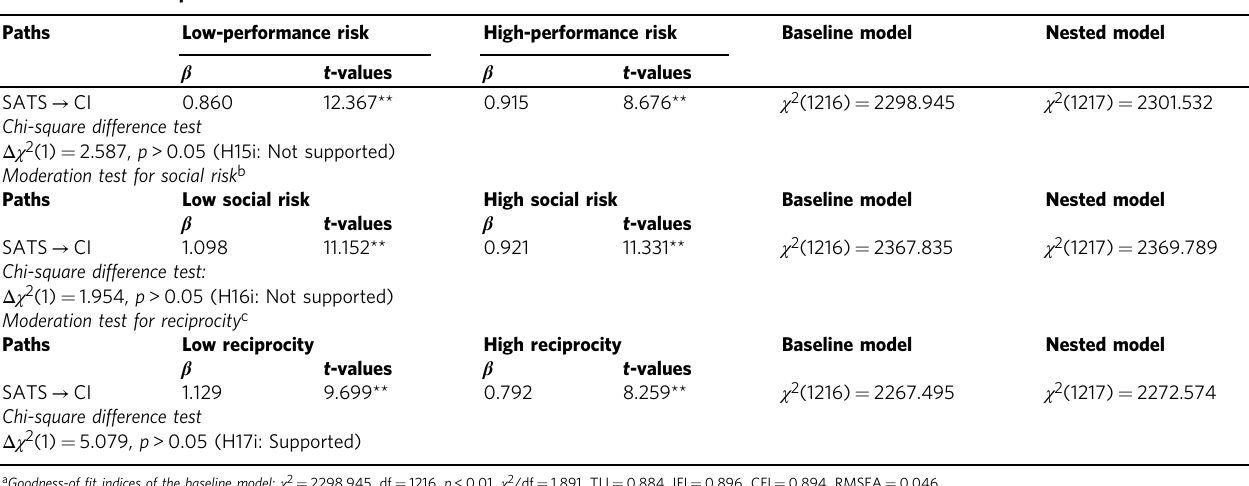
Table 4 Assessment of multigroup moderating effect. Moderation test for performance risk